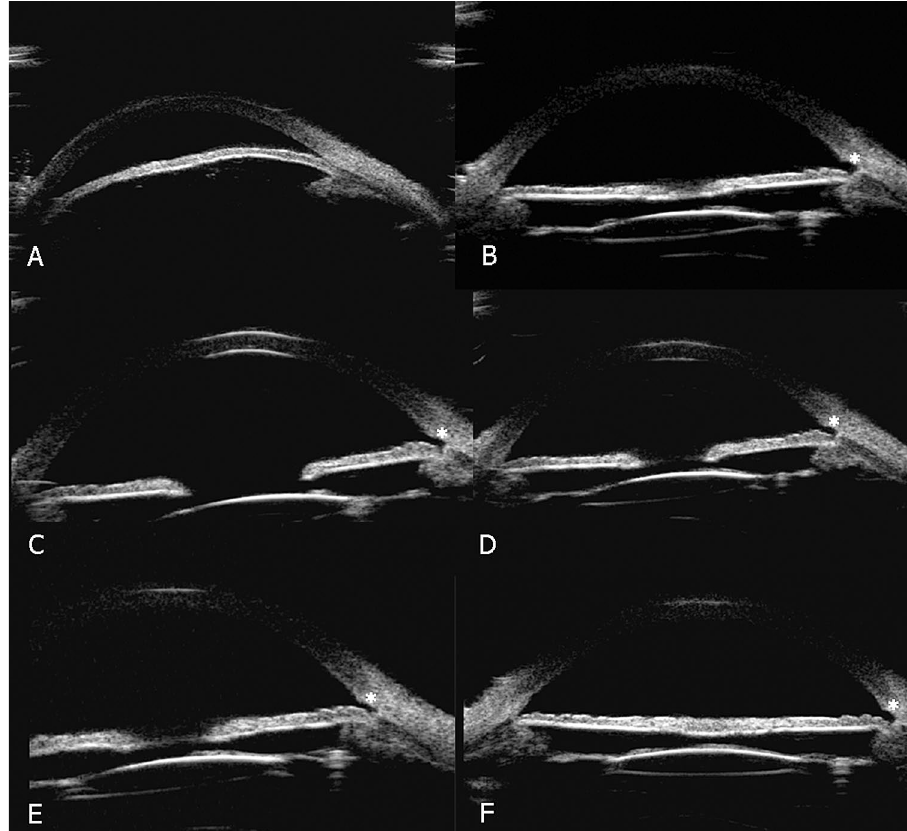
Figure 2. Series ultrasound biomicroscopy (UBM) image of a representative case of primary angle-closure glaucoma after combined phacoemulsification, intraocular lens implantation, goniosynechialysis and trabectome. This representative case was an 81-year-old man with blurred vision for 10 years in the left eye. His best corrected visual acuity (BCVA) was 0.05 and intraocular pressure (IOP) was 20.5 mmHg with the use three anti-glaucoma medications at baseline. ( A ) UBM image preoperatively showed that the anterior chamber angle on the nasal side was closed. ( B – F ) UBM image 1 month, 3 months, 6 months, 12 months, and 24 months after surgery demonstrated that the narrow chamber angle had been deepened. At 24 months, the IOP decreased to 14 mmHg with only one medication. White asterisks represent the position that underwent trabectome.